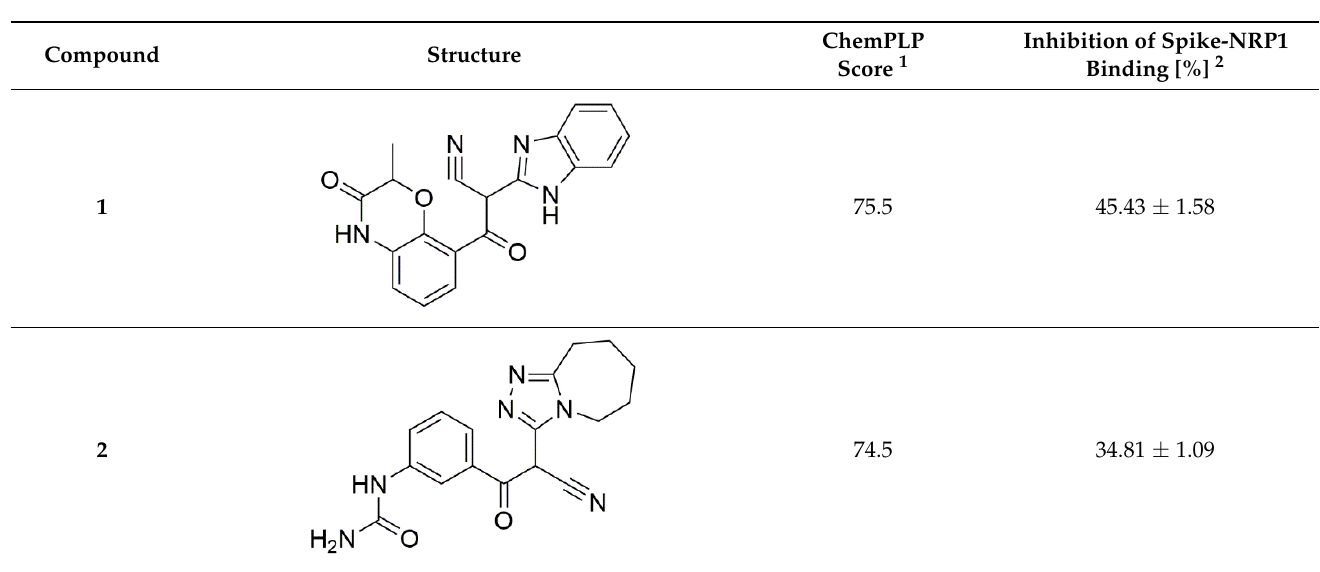
Figure 3. Library preparation for molecular docking calculations on the b1 domain of NRP1. The final library contained 956,355 molecules. Table 1. Inhibition of the spike S1 binding to NRP1 by the compounds selected using molecular docking calculations.